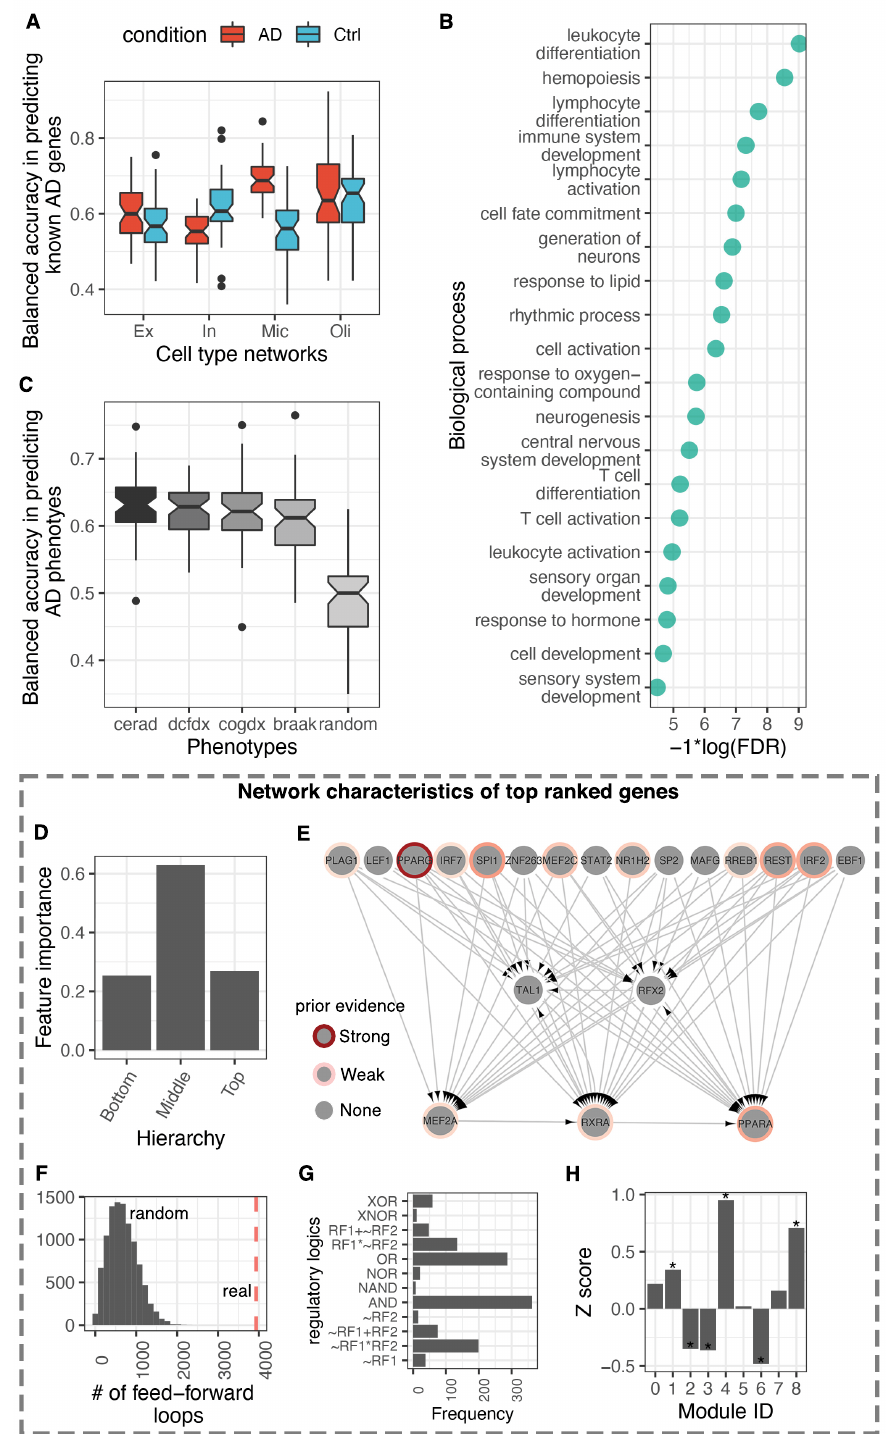
Fig 6. AD Gene prioritization and clinical phenotype prediction using network-based machine learning. ( A ) Boxplots showing the distribution of balanced accuracies (y-axis; obtained from 10 independent runs of five-fold cross-validation) in predicting known AD genes using interaction patterns in cell type GRNs as features (x-axis). ( B ) Gene ontology biological process terms enriched within the top 20% predictions in the microglia AD machine learning (ML) model. The terms are depicted along the y-axis, and the FDR corrected p -values are shown along the x-axis. ( C